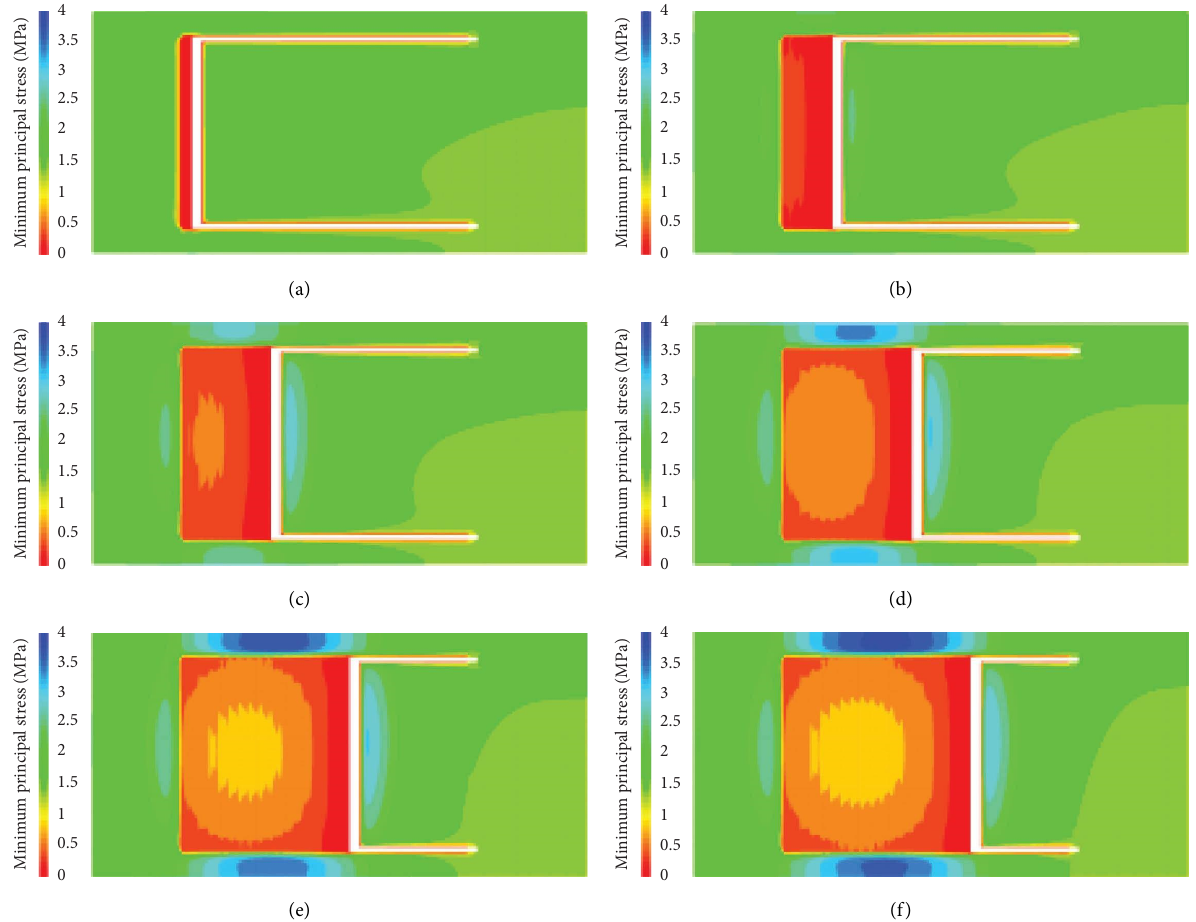
Figure 4: Distribution characteristics of minimum principal stress under diferent propulsion distances: (a) advance 32m, (b) advance 96m, (c) advance 160m, (d) advance 224m, (e) advance 228m, and (f) advance 352